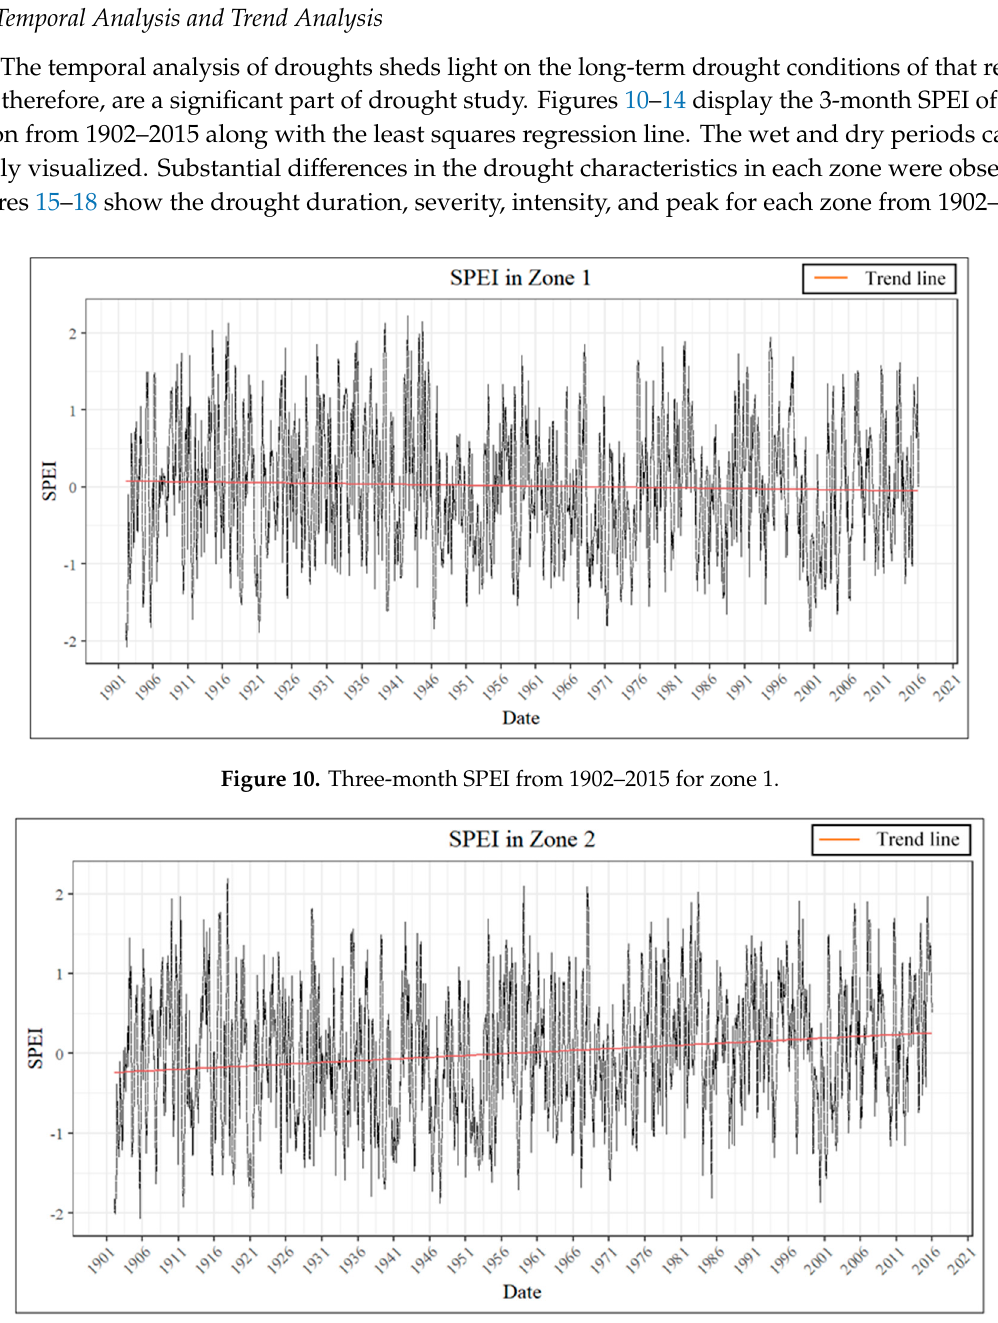
Figure 11. Three-month SPEI from 1902–2015 for zone 2.